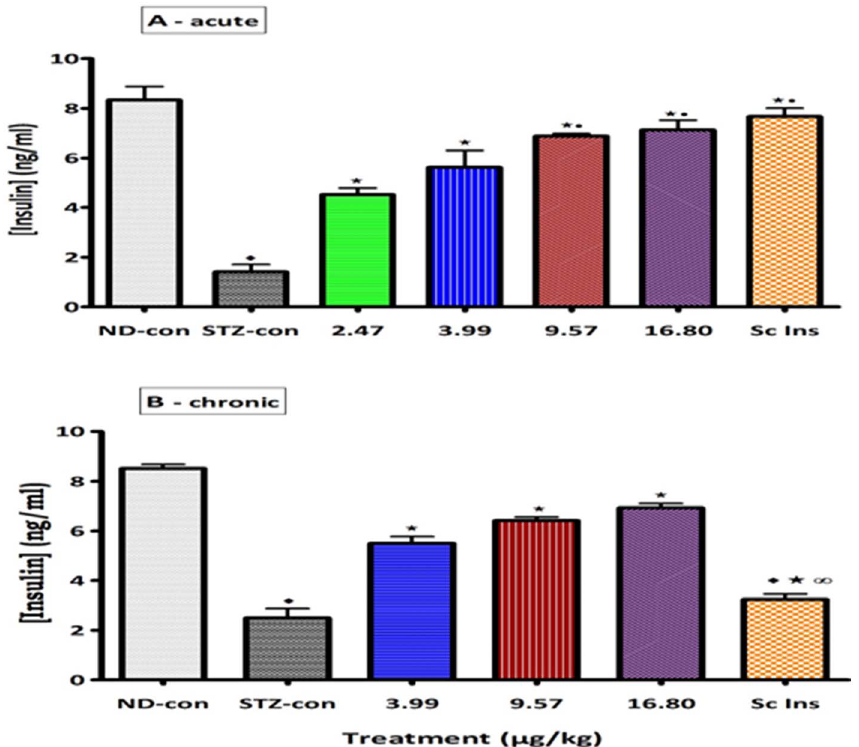
Figure 4. Comparison of plasma insulin concentrations of STZ-induced diabetic rats to PI matrix patches of different insulin concentrations with control animals. Values are presented as means, and vertical bars indicate SEM of means (n=6 in each group). ¤ p , 0.05 by comparison Non-diabetic control. w p , 0.05 by comparison to STZ-induced diabetic control. by comparison to transdermally PI treated